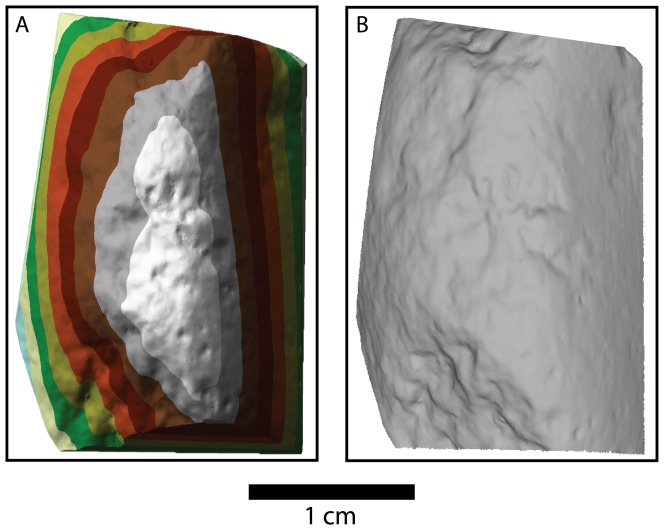
A three-dimensional model of one of the fine grained igneous experimental hammerstones used in this study.A) a TIN model of the surface scan of this experimental hammerstone; B) a hillshade model of the same scan as in A, highlighting the percussive damage on the surface of this experimentally made hammerstone. Notice the difference in surface roughness between the left side versus the right side of the scan.